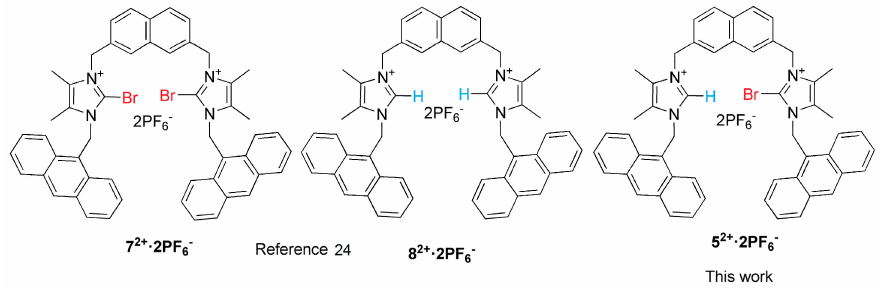
Figure 1. Structure of the halogen and hydrogen bonding receptors 7 2+ · 2PF 6 − and 8 2+ · 2PF 6 − reported in [24] and the structure of the mixed halogen and hydrogen bonding receptor 5 2+ · 2PF 6 − proposed in this